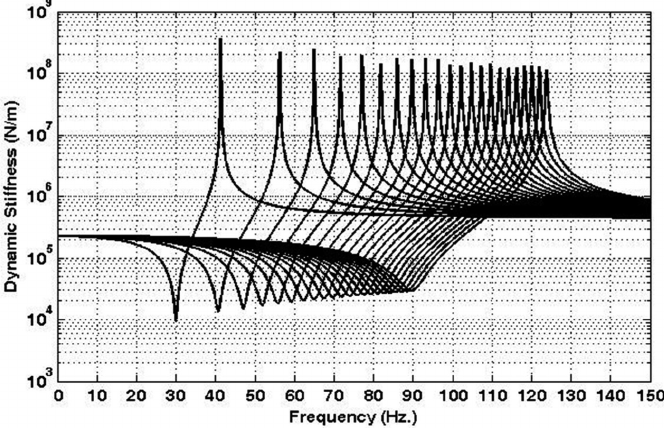
Fig. 4. Dynamic stiffness of the hydraulic mount when resistance is constant.